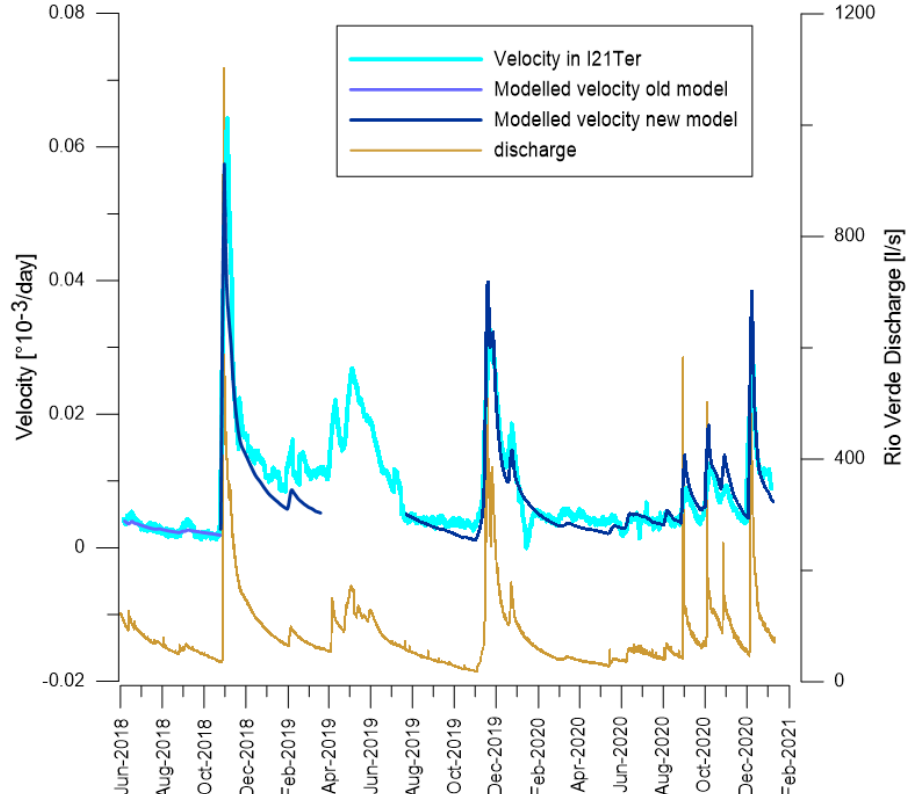
Figure 8. Modeled velocities based on the gray-box models (pre- and post- Vaia storm) and the Rio Verde discharge.